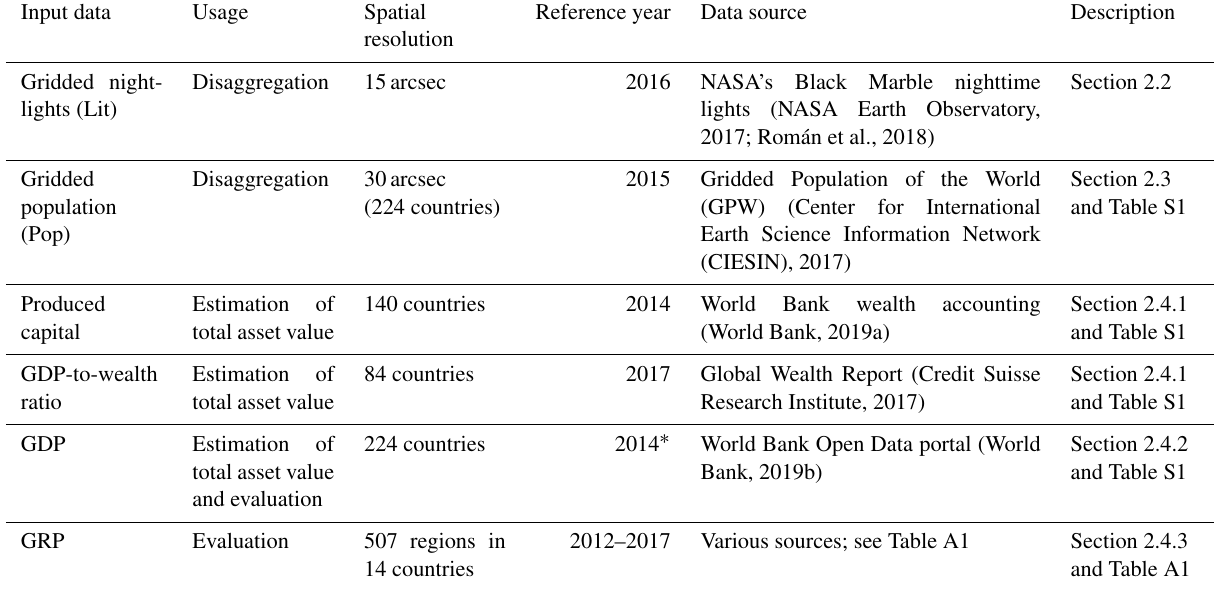
Table 1. Overview of input dataset, including information on usage, resolution, reference year, data source, and references. The reference year indicates the year for which the data used were provided. ∗ For GDP, the value of 2014 in current US dollars was used for 203 countries. For 21 countries without GDP data available for 2014, the closest available data points from the years 2000 to 2017 were used